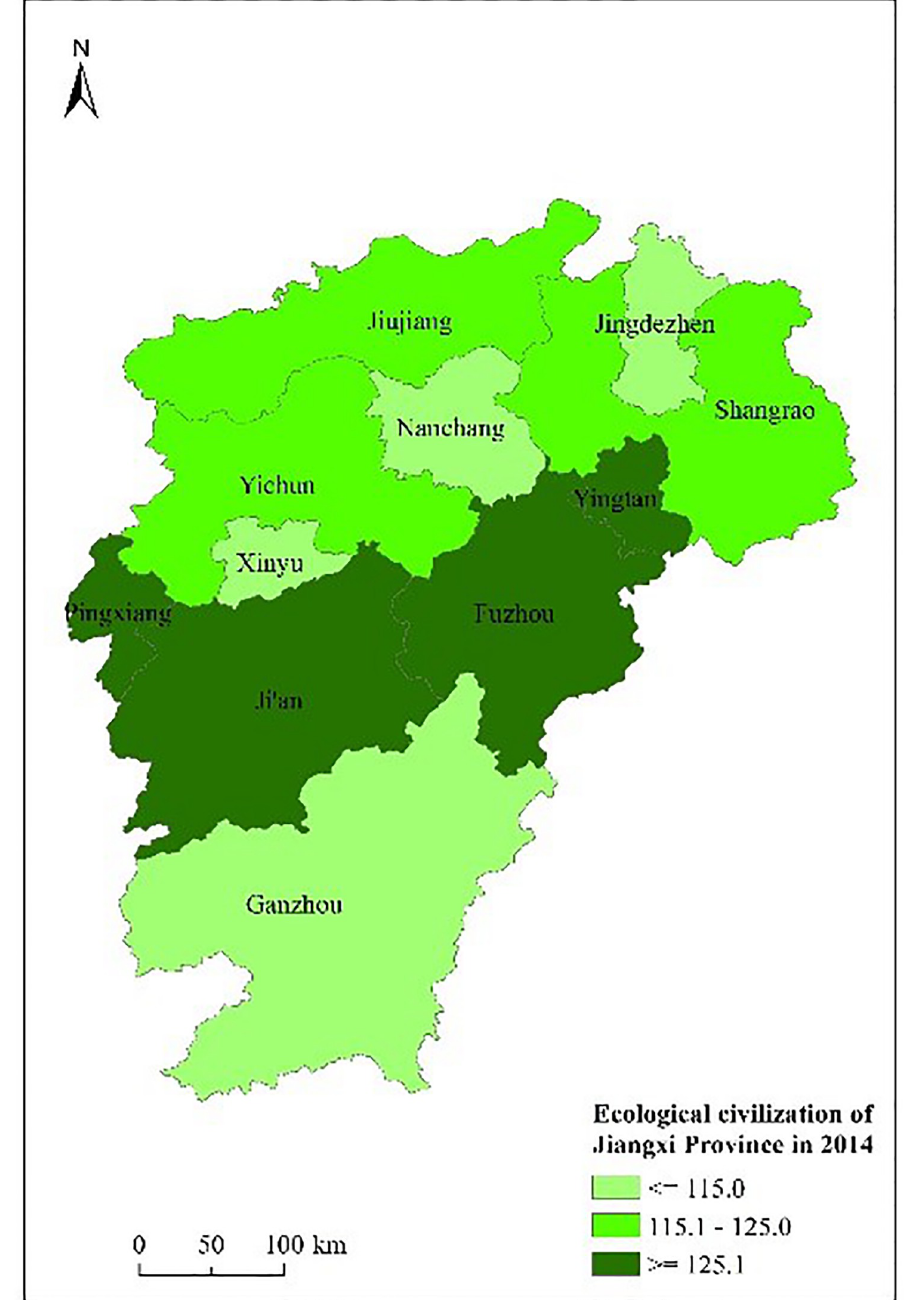
Fig 7. Space distribution of ecological civilization of Jiangxi Province (base map and data from OpenStreetMap and OpenStreetMap foundation. Contains information from OpenStreetMap and OpenStreetMap foundation, which is made available under the Open Database license. Data source comes from Table 4). Source: Republished from Jiangxi Provincial Bureau of Statistics under a CC BY license, with permission from China Statistics Press, original copyright 2010 to